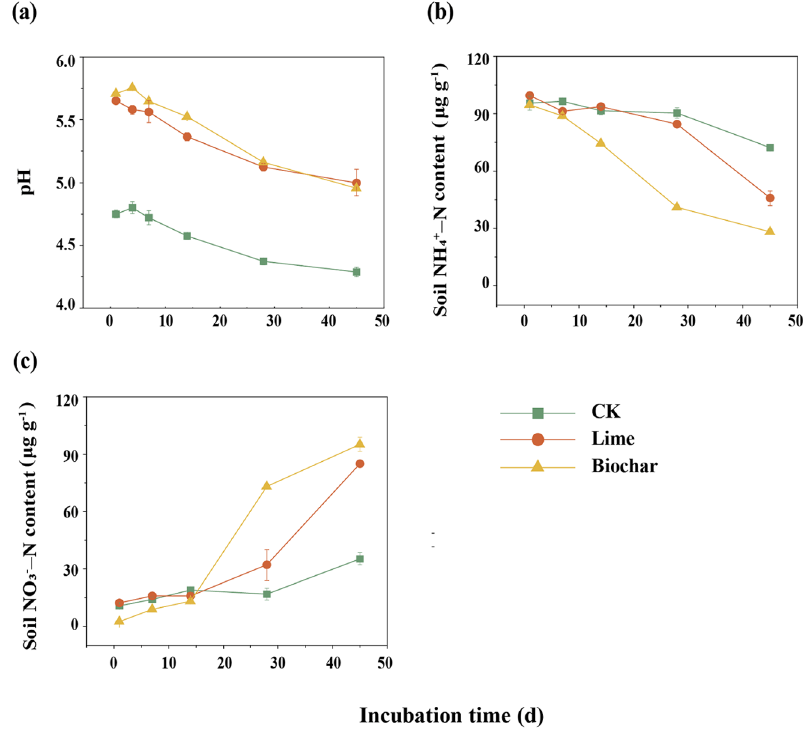
Figure 1. Changes in soil pH ( a ), NH 4+ − N ( b ) and NO 3 − − N ( c ) during the 45 − day incubation period under di ff erent treatments. Error bars indicate standard deviations ( n = 3).